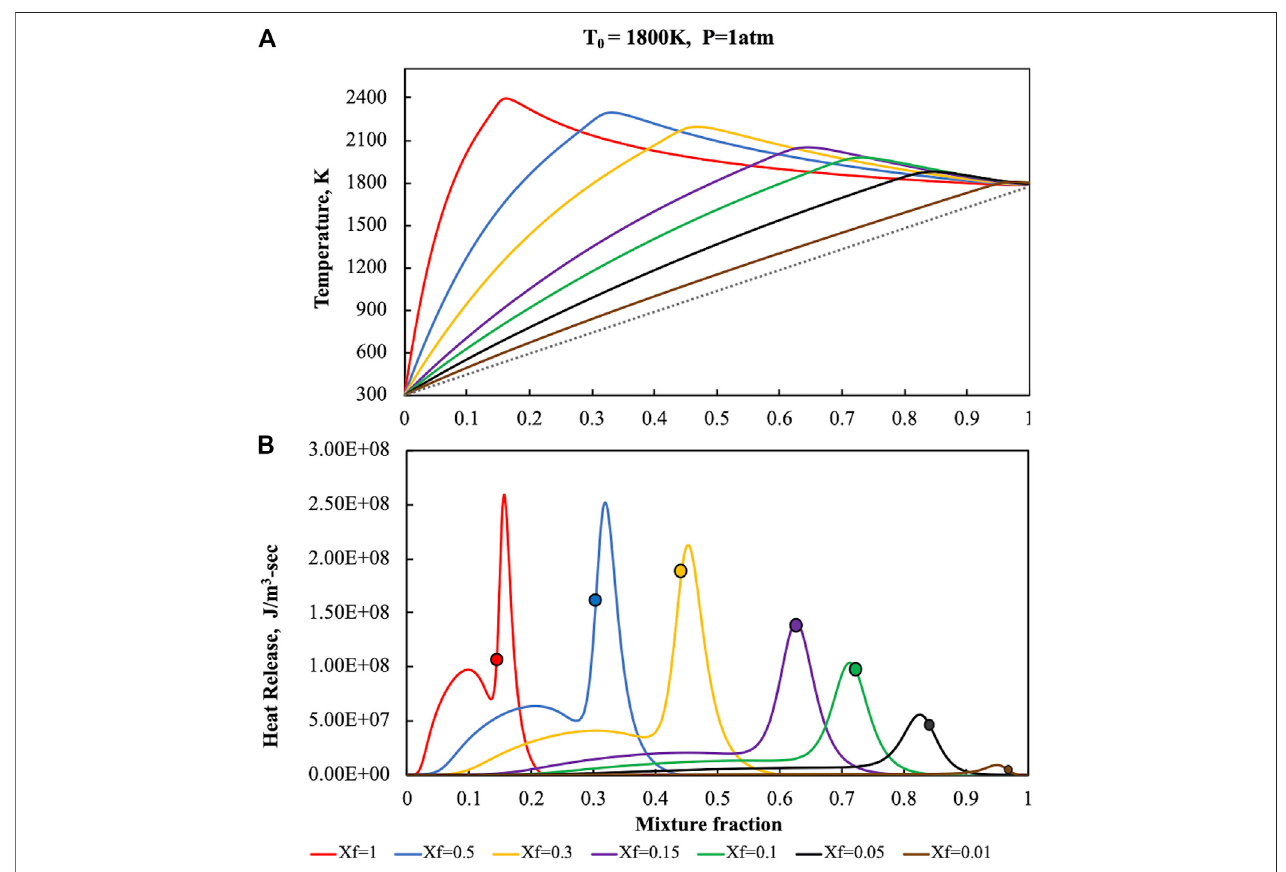
FIGURE 2 | Temperature (A) and heat release (B) pro fi les for pure ammonia parametric in X f in the HFDF con fi guration for T 0 (cid:1) 1,800 K, K 0 (cid:1) 50 s − 1 , P (cid:1) 1 Atm.